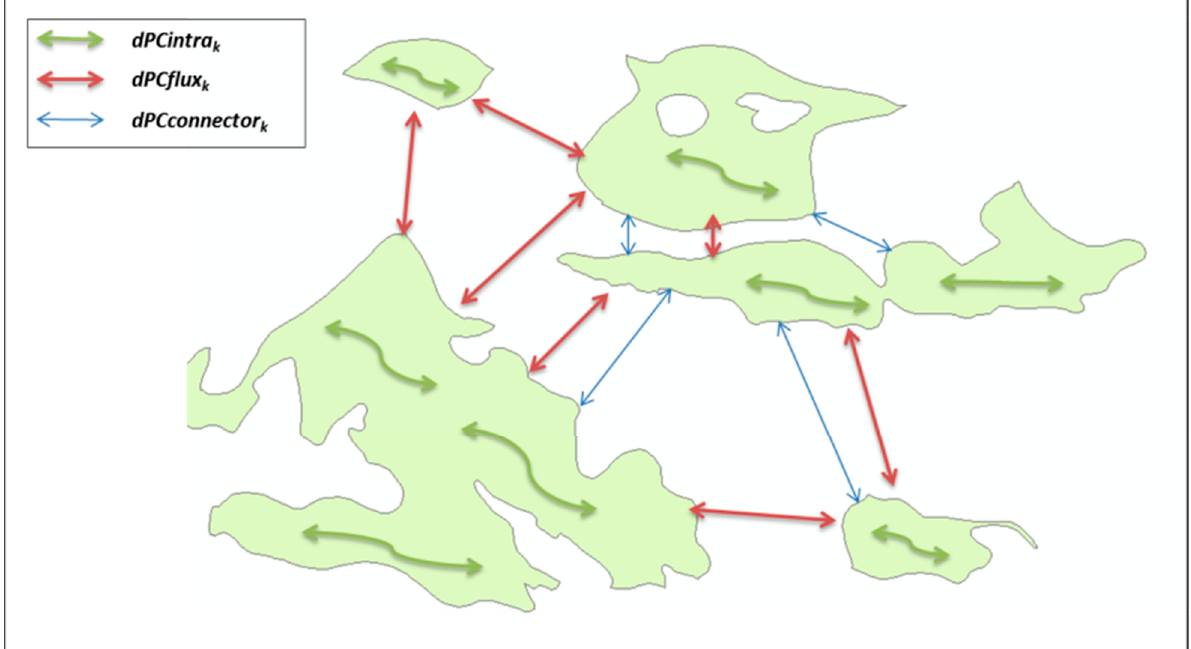
Figure 3. Schematic representation of the three different components of dPC. The value of dPC intra represents the internal connectivity of the patch, dPC flux describes the role of each patch in connecting to surrounding patches (direct connection) and dPC connetor describes the role of a patch as a stepping stone (intermediate patch).